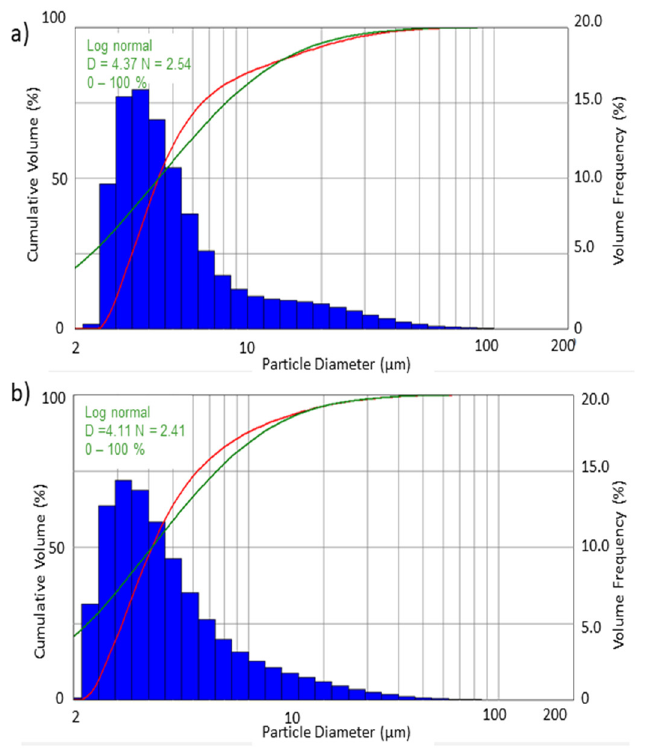
Figure 7. Numerical distribution of droplet diameters obtained at a distance of 1 m: ( a ) plastic filter, ( b ) ceramic filter.